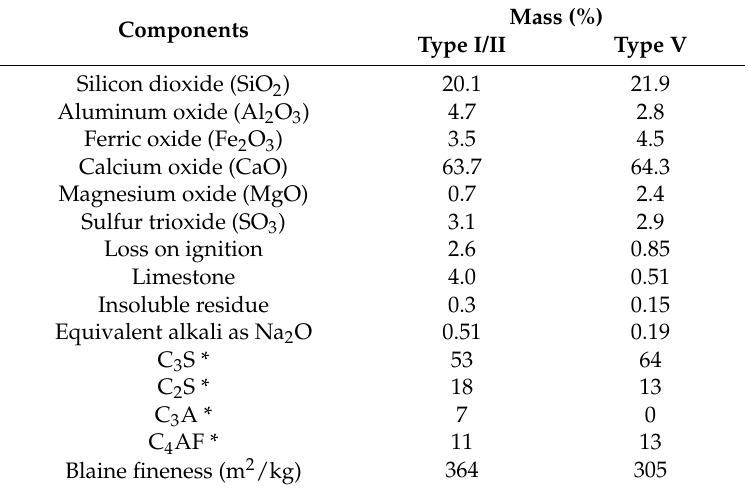
Table 1. Cement Chemical